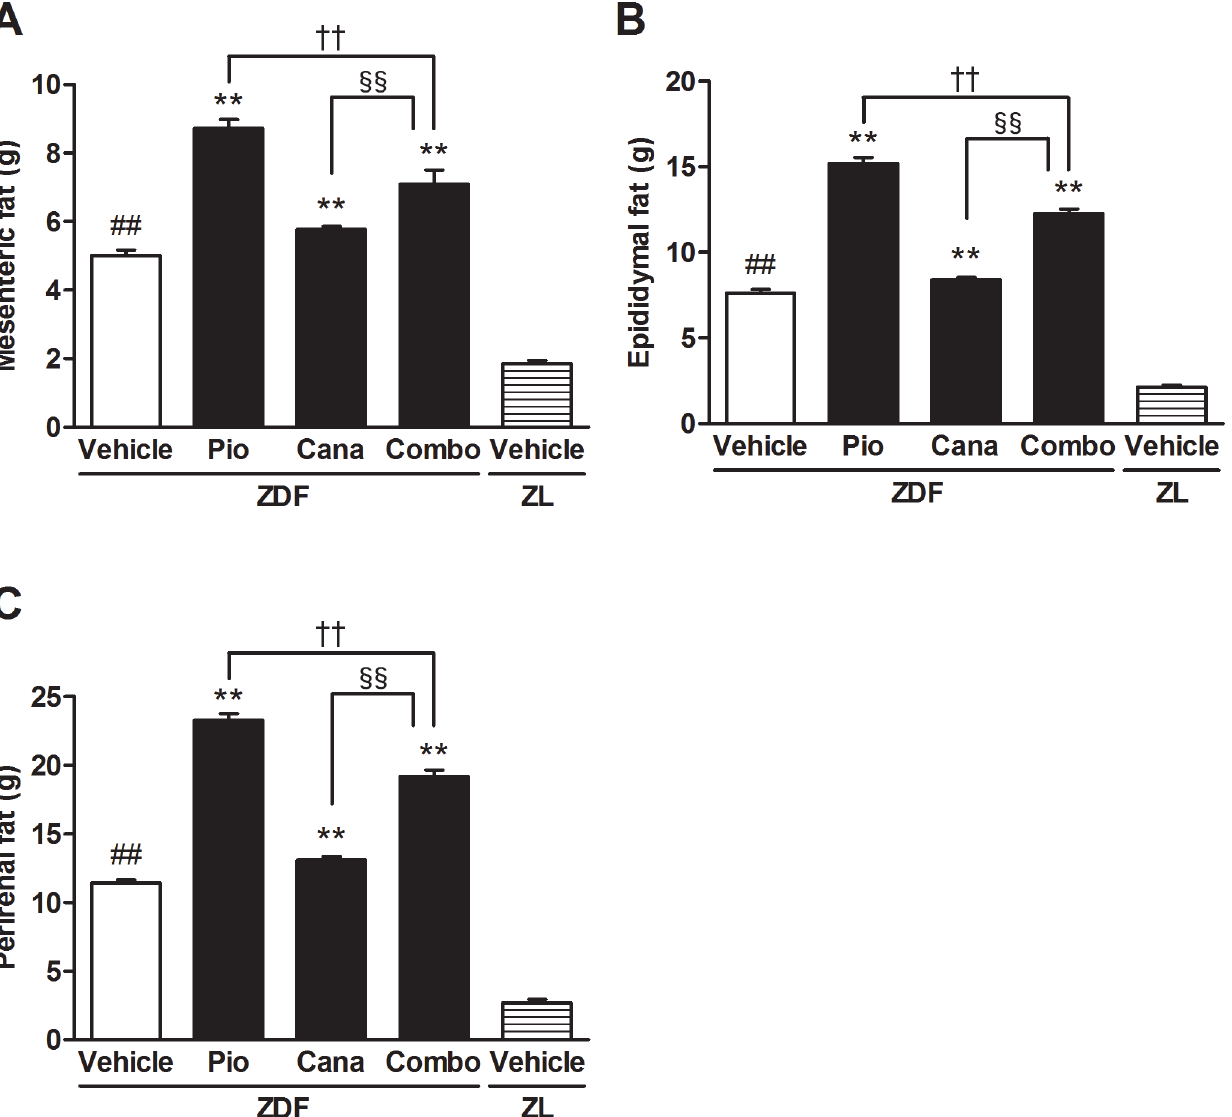
Figure 5. The adipose tissue weight of ZDF and ZL rats. A: Mesenteric fat, B: Epididymal fat, and C: Perirenal fat. Canagliflozin (Cana; daily dose of 10 mg/kg), pioglitazone (Pio; daily dose of 10 mg/kg), and their combination (Combo) were administered by oral gavage for 6 weeks. Adipose tissue weight was measured at the end of the study. Data are expressed as mean ± SEM (n = 8). ## P < 0.01 vs. ZL rats, ** P < 0.01 vs. vehicle-treated ZDF rats, †† P < 0.01 vs. Pio-treated ZDF rats, §§ P < 0.01 vs. Cana-treated ZDF